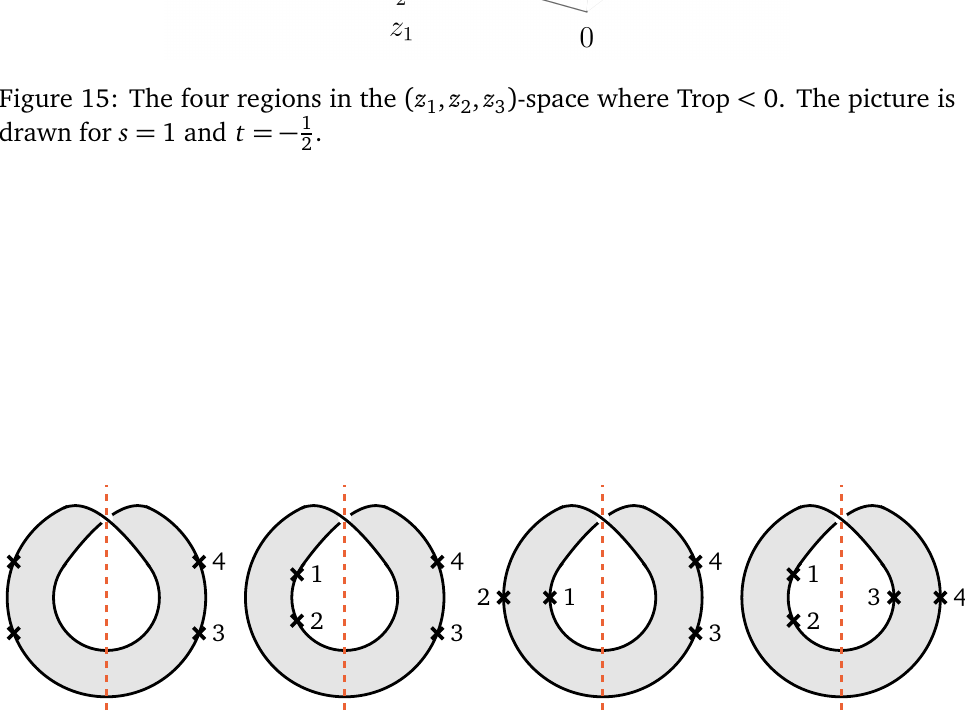
Figure 15: The four regions in the ( z drawn for s = 1 and t = − 1